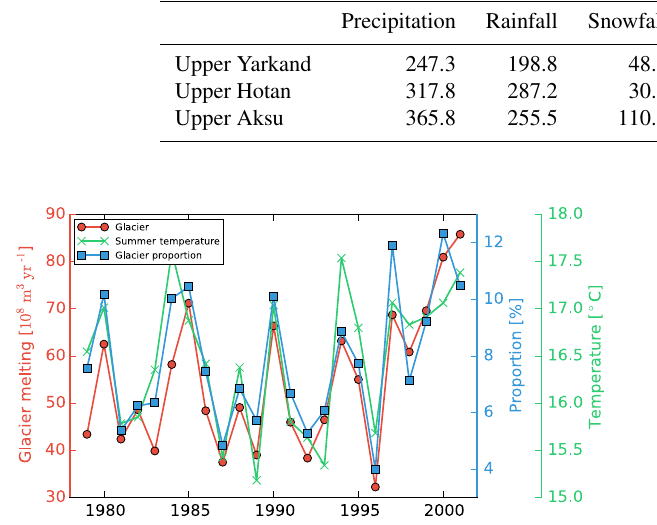
Figure 5. The temporal variations of the glacier melt, the proportion of glacier melt in the water input and the average summer temper- ature over the upper Tarim Basin. They are in good correlation and have a consistent increasing trend after